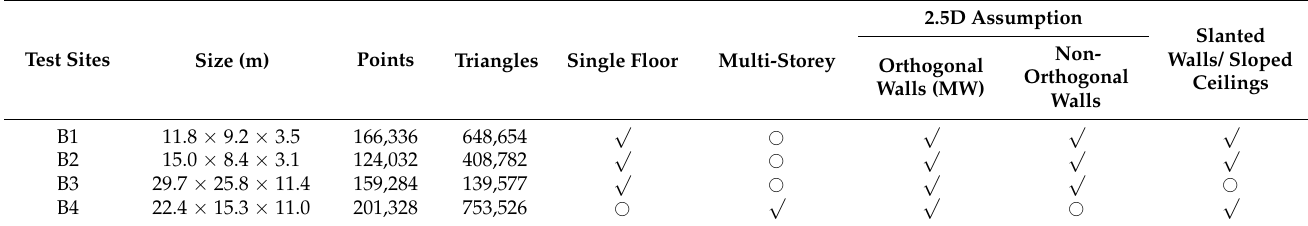
Table 5. Detail descriptions of the experimental mesh datasets.